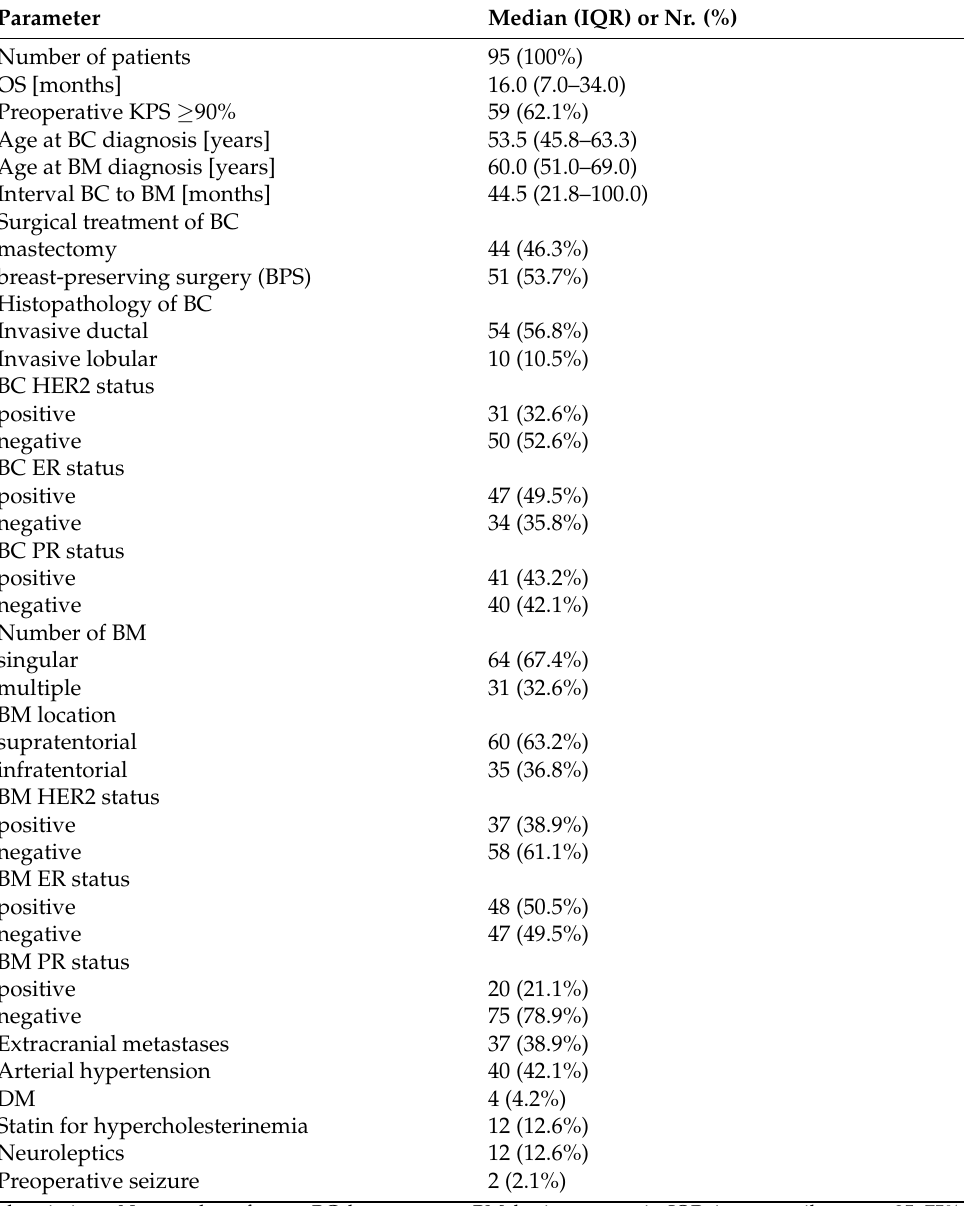
Table 1. Baseline characteristics of BCBM